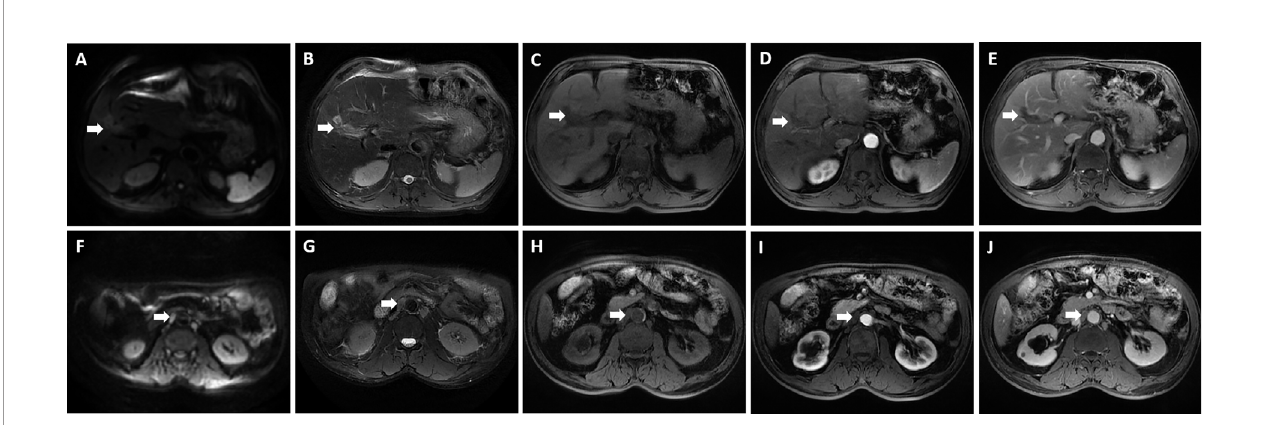
FIGURE 5 | Preoperative magnetic resonance imaging was performed for the patient. The reduced lesion with clear boundary has low signal in T1-weighted imaging, high signal in T2-weighted imaging, and limited diffusion in diffusion-weighted imaging (DWI); enlarged hepatic portal and retroperitoneal lymph nodes were also revealed — the larger one was about 10 mm in diameter. (A, F) DWI; (B, G) T2-weighted imaging; (C, H) T1-weighted imaging; (D, I) The arterial phase; (E, J) The delayed phase. The white arrowheads direct the lesion or enlarged lymph nodes.